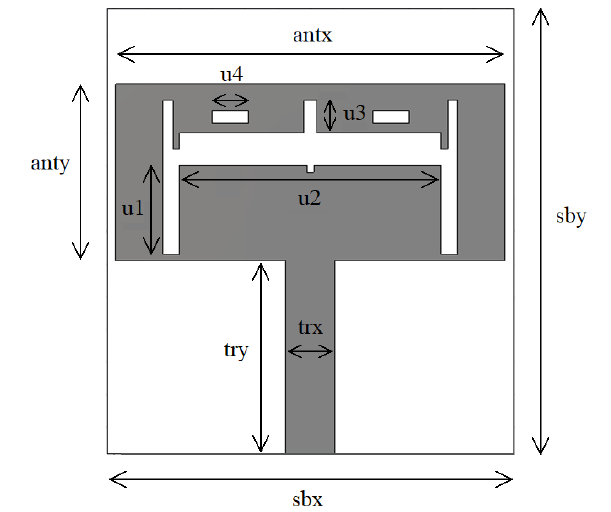
Fig. 1. Antenna structure.